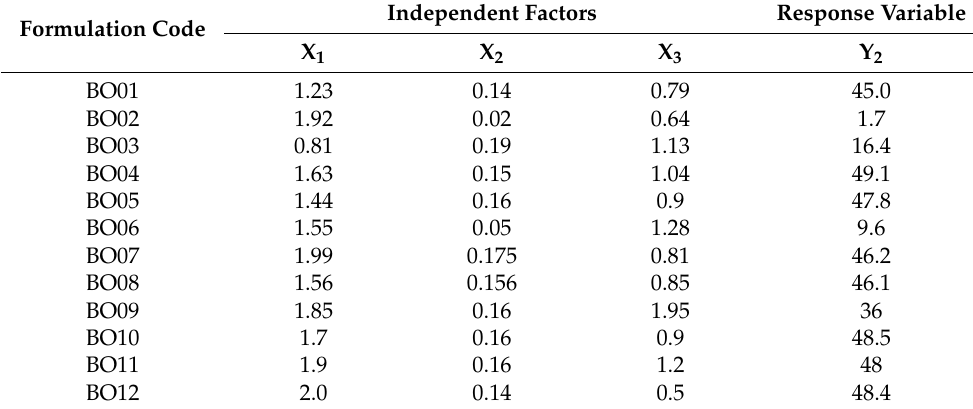
Table 7. The cumulative experiment design matrix proposed by BO and Y 2 response